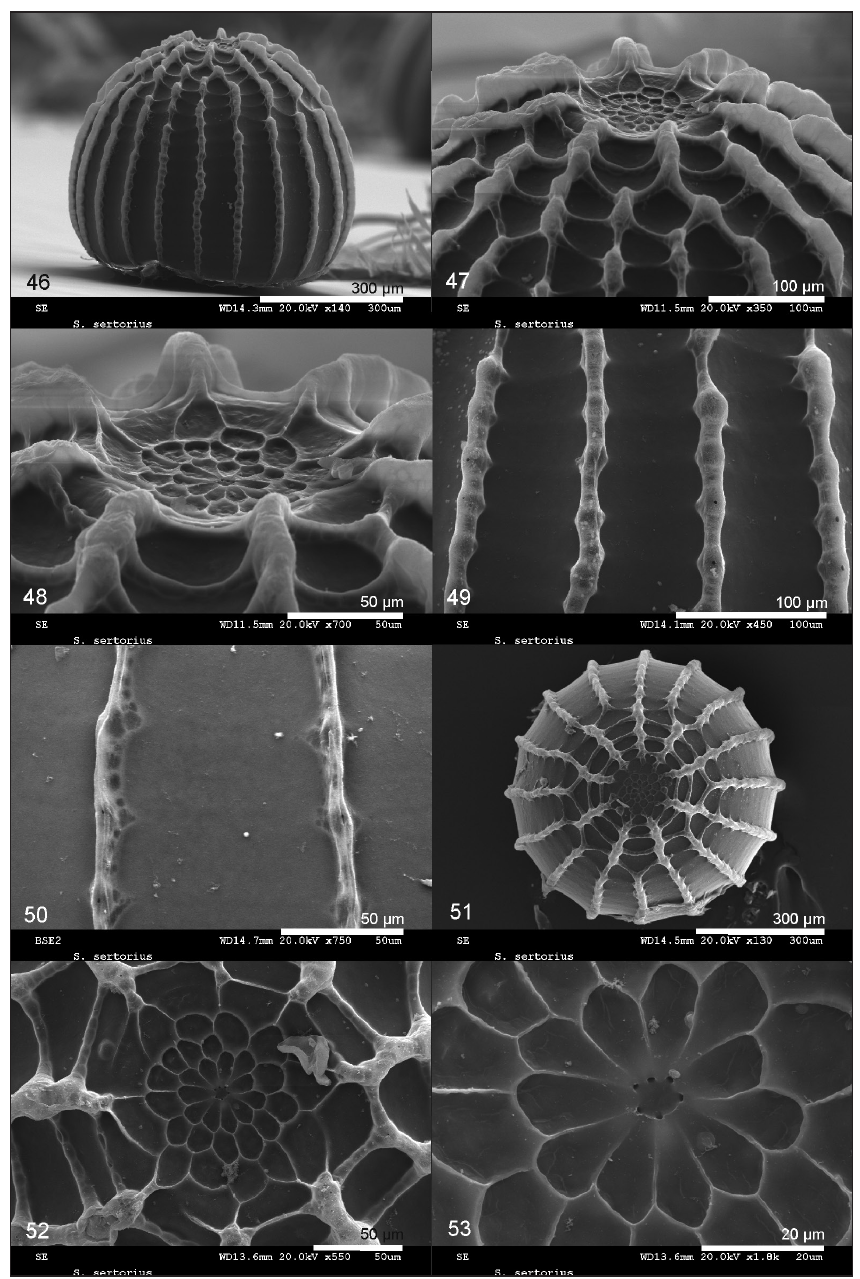
Figures 46–53. Scanning electron microscope images of an egg of Spialia sertorius from Vallelado, Segovia, Central Spain. 46. Lateral view. 47. Lateral view of the annular area. 48. Detail of the annular area. 49. Cells of the egg equator formed by radial and transverse ribs. 50. Detail of the radial ribs. 51. View of the annular pole. 52. Annular area with the micropylar rosette. 53. Micropylar rosette and micropyle showing six micro- pylar